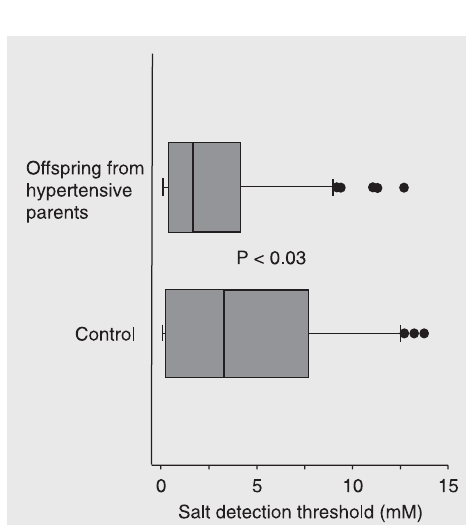
Figure 4. Salt detection thresh- old in the offspring of control and hypertensive parents. Box verti- cal sides represent the lower and upper quartile (enclosing the middle half of the sample); the sample median, as the verti- cal line inside; whiskers sprout from the two ends of the box until they reach the sample maximum and minimum, ex- cluding outliers - black symbols (cases with the values between 1.5 and 3 box-lengths from the 75th or 25th